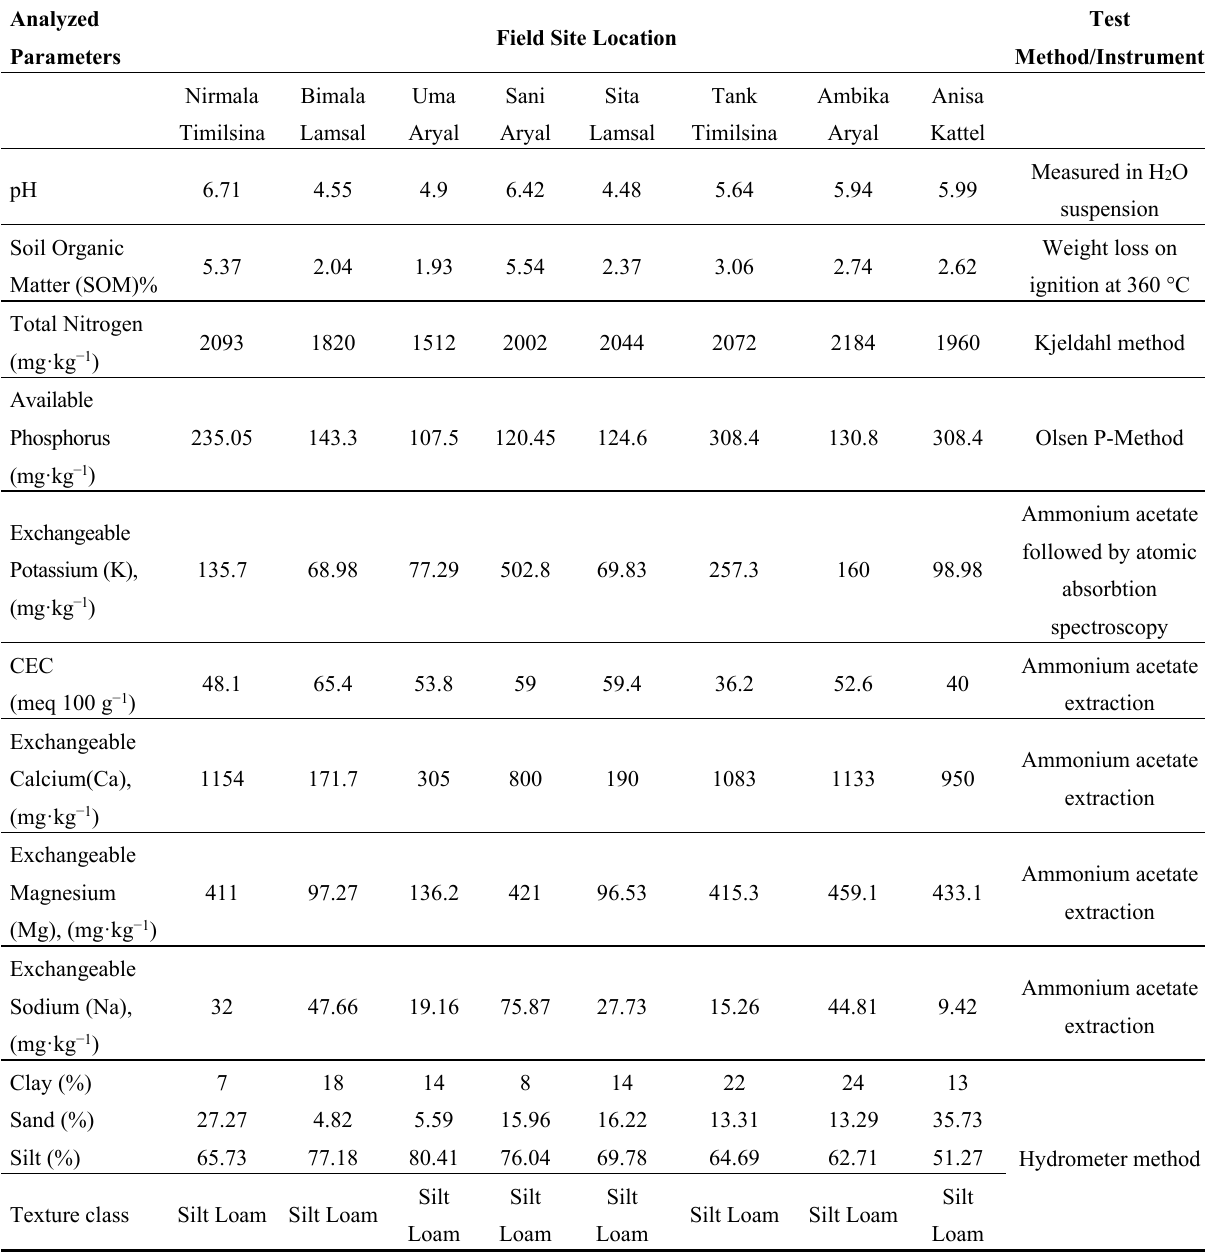
Analytical parameters and methods of the eight trial soil samples; each soil sample was mixed from 12 randomly distributed soil cores collected from a depth of 2 to 20 cm before trial